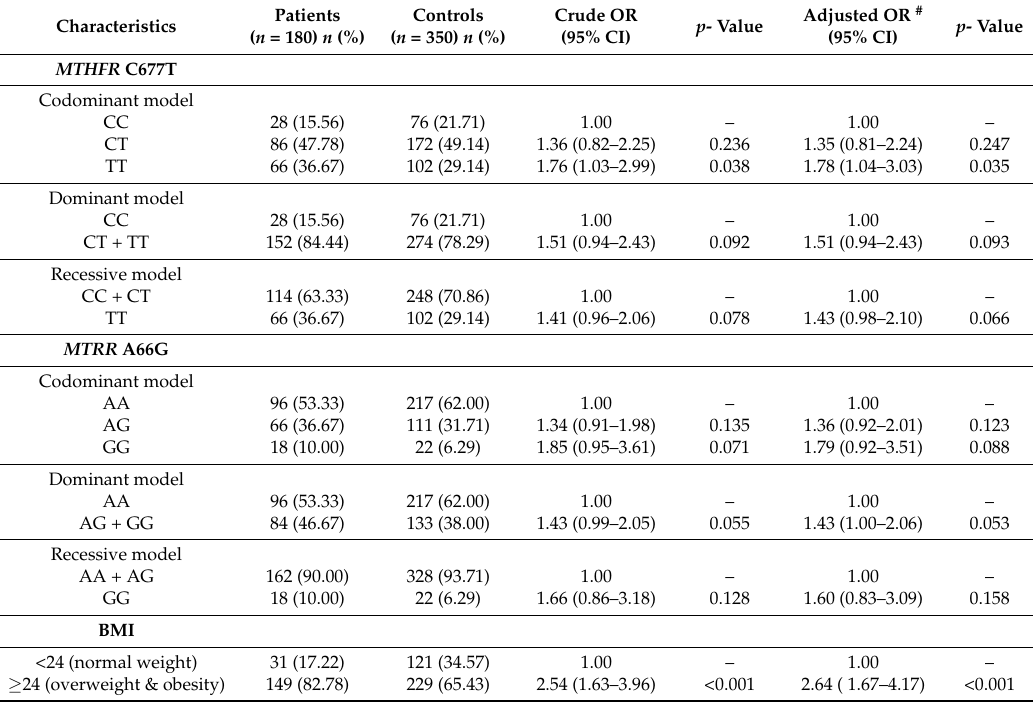
Table 2. Associations of high BMI, the MTHFR C677T and MTRR A66G polymorphisms with type 2